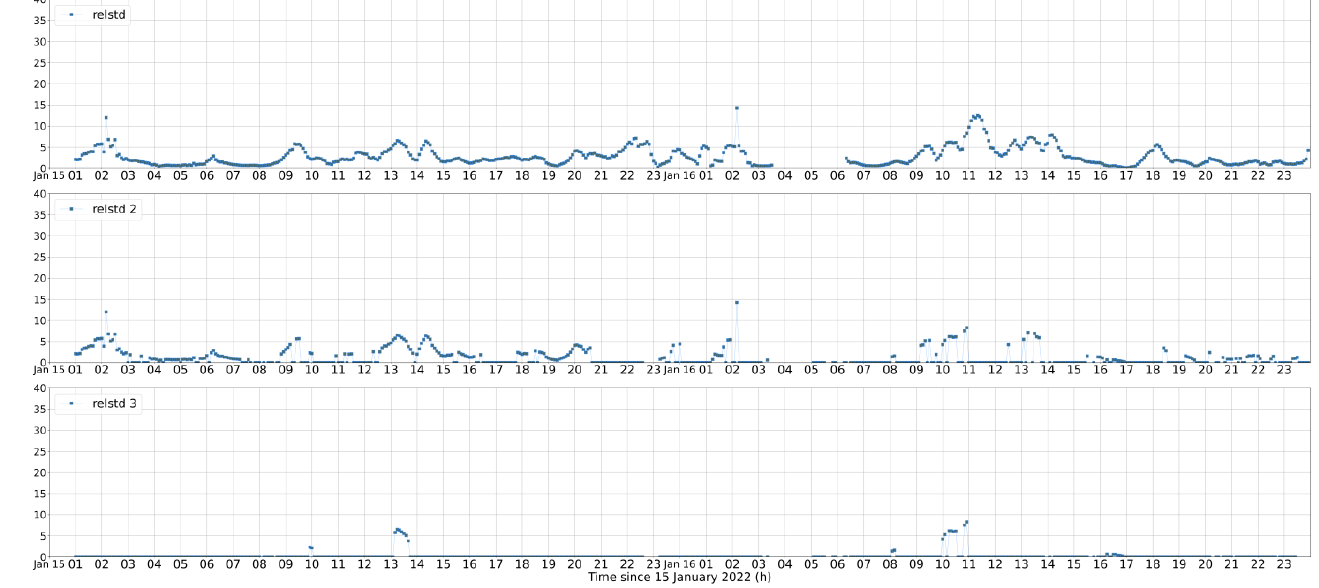
Figure 13. The same as Figure 12, for Dourbes.